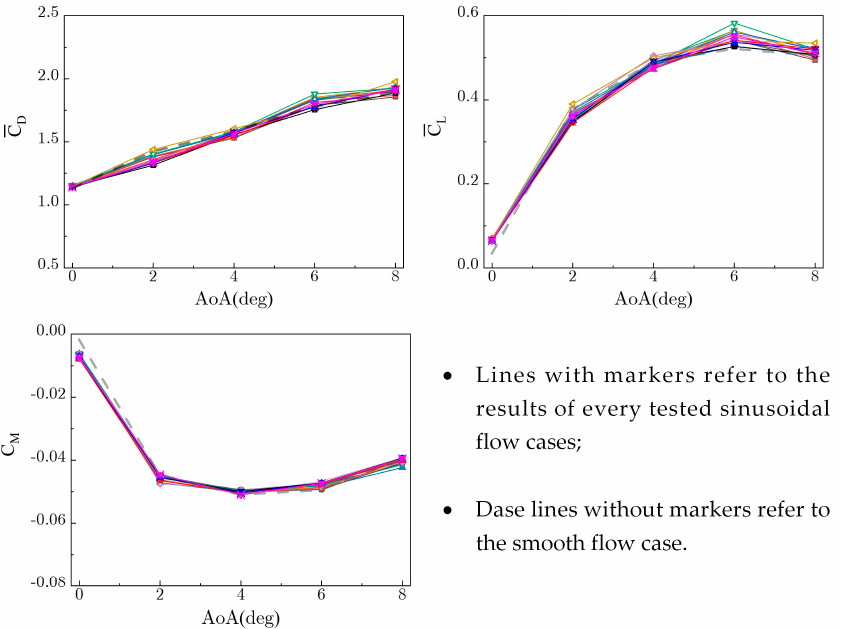
Figure 8. Time-averaged C D , C L , and C M of all cases.